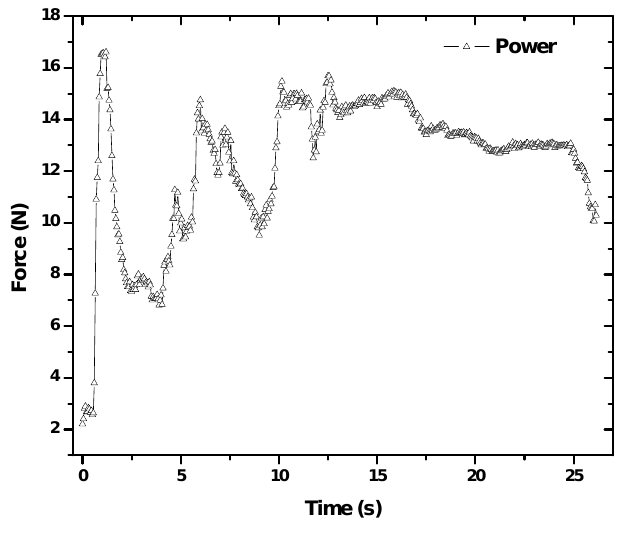
Figure 4. Forces measured during the entire incision opening